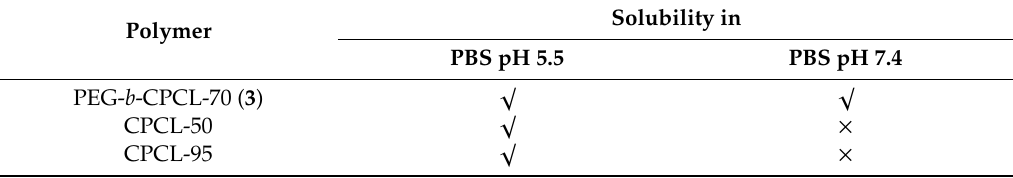
Table 1. Solubility of CPCLs and PEG- b -CPCL ( 3 ) in 25 mM PBS bu ff er at pH 5.5 and 7.4 at 37 ◦ C.